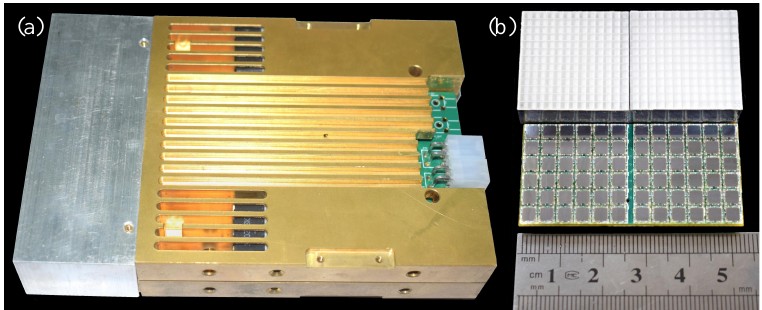
Figure 2. Photographs of the BDM ( a ) and 13 × 13 LYSO crystal array with the 6 × 6 SiPM array ( b ).